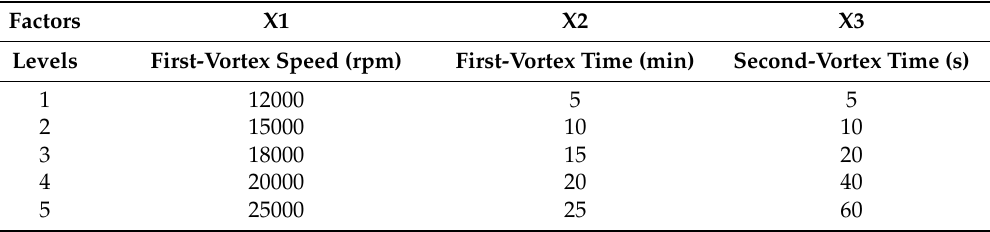
Table 1. The factors and levels of preparation